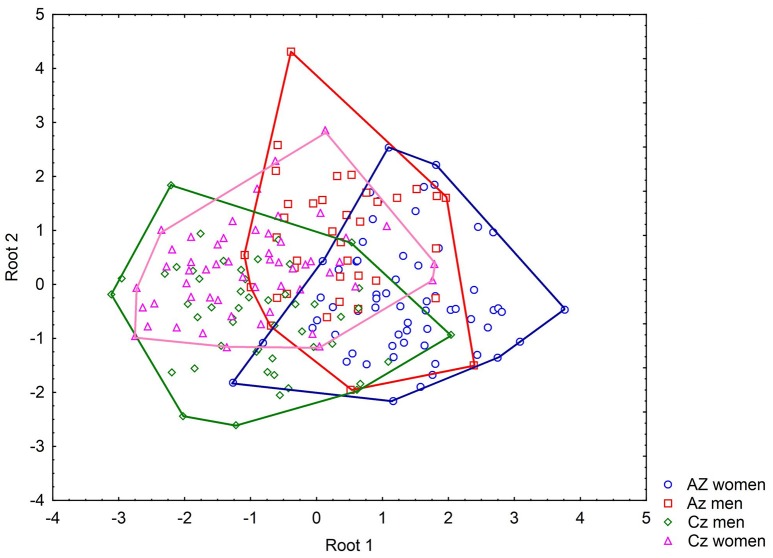
The canonical DFA of fear evaluation. This analysis showed significant differences between the sexes and countries when comparing the Azerbaijani women to all other groups and the Azerbaijani men to the Czech respondents. However, a plot of the first two canonical factors showed a considerable overlap of the groups for elicited fear. The number of included species was reduced by the forward stepwise procedure to just 17 out of 36. Three species, the meadow viper (Vipera ursinii; Wilks' lambda = 0.3850, p = 0.0042), the coastal viper (Montivipera xanthina; Wilks' lambda = 0.3975, p = 0.0002), and the Palestine saw-scaled viper (Echis coloratus; Wilks' lambda = 0.3898, p = 0.0014) had the largest Wilks' lambda and therefore, corresponded the best with the discrimination criteria. Thus, only three of the 36 tested snake species are responsible for the detected differences in fear evaluation.